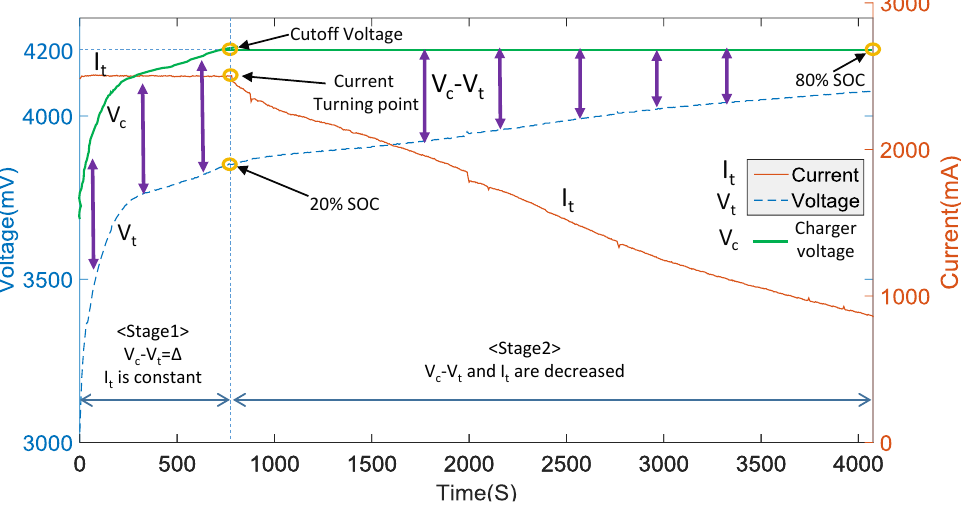
Figure 2. Charger voltage and cell terminal voltage.